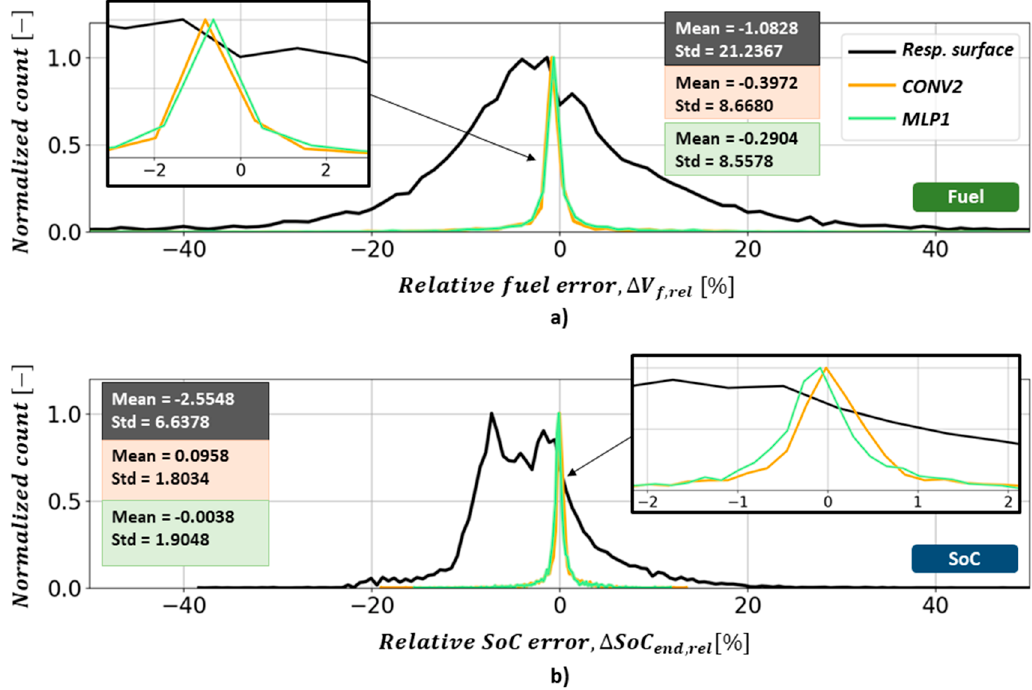
Figure 12. Distribution of normalized relative residuals of predicted fuel consumptions ∆ V f,rel ( a ) and SoC-at-destinations ∆ SoC end,rel ( b ).